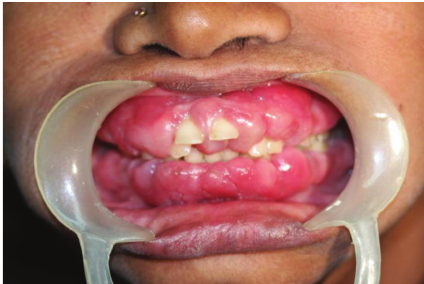
Figure 3: Laser settings for excision of the tissue.